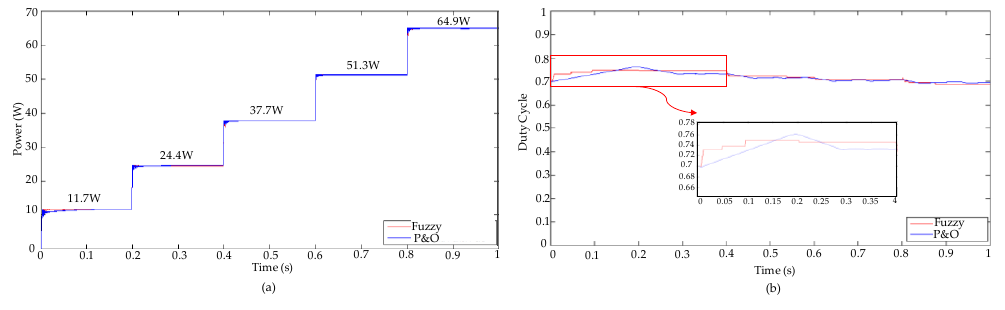
Figure 16. ( a ) Output power of the PV module for increases in solar irradiance; ( b ) Duty cycle. In Figure 17a, the output power for decreases in the irradiance signal is shown. As with the increase signal, the two controllers exhibit good performance with output power between 64.9 W and 11.7 W. Figure 17b shows the duty cycle, in which it is noted that the P&O controller presents the oscillations that characterize this method, but that do not significantly affect the performance of the system.